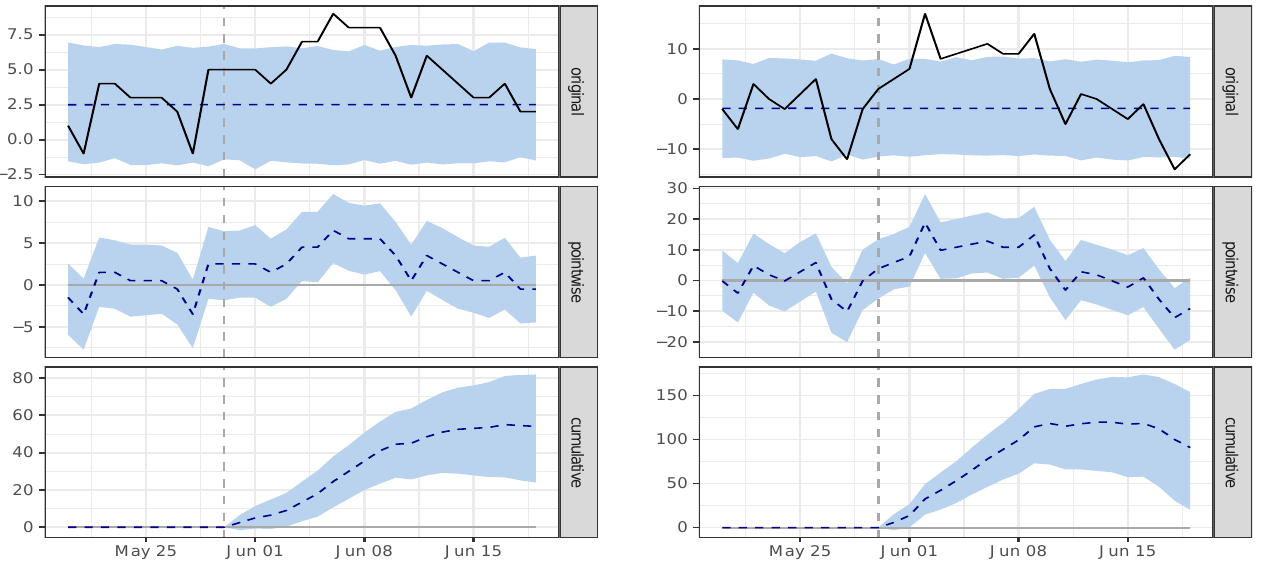
Figure 16. Left : Effect of the national full lockdown Level 5 on workplaces Right : Effect of the national full lockdown Level 5 on transit